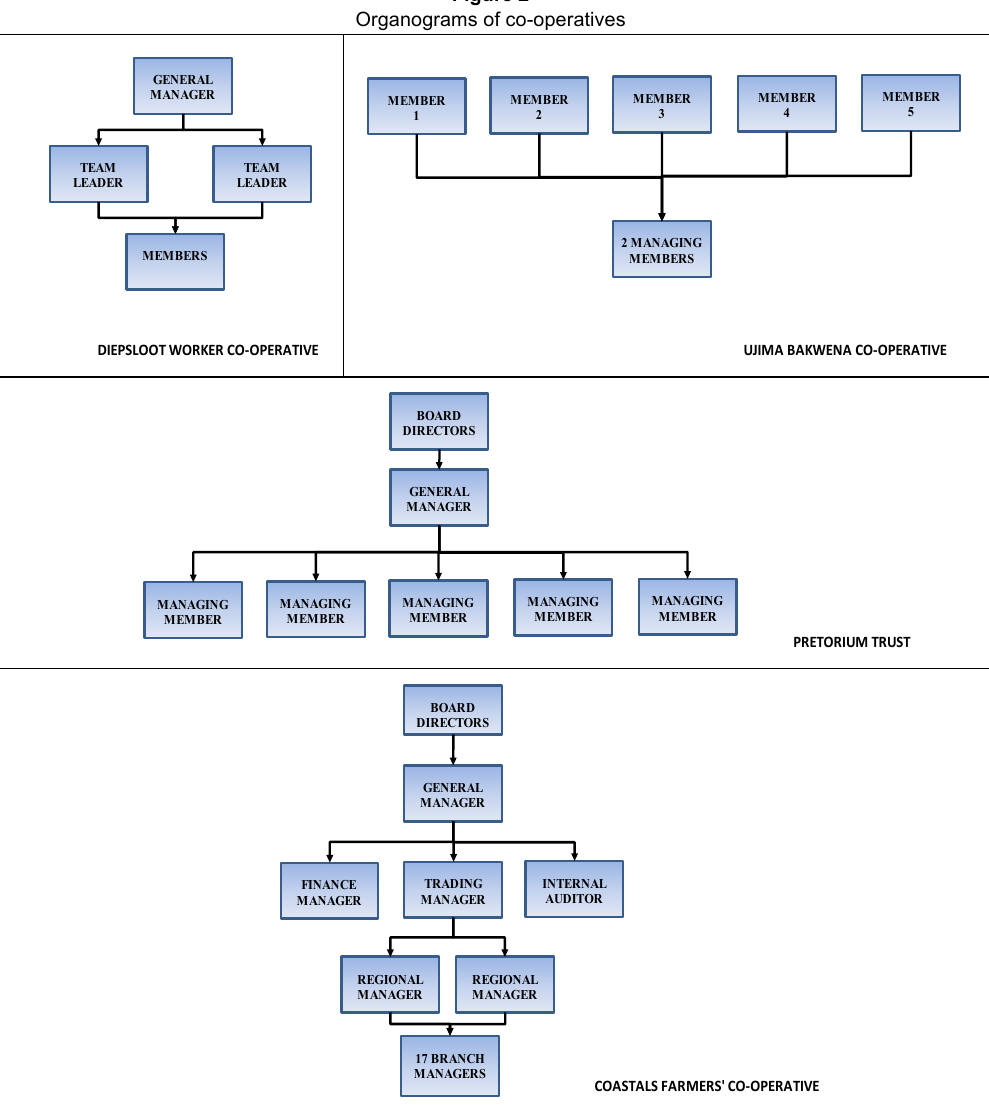
Figure 2 Organograms of